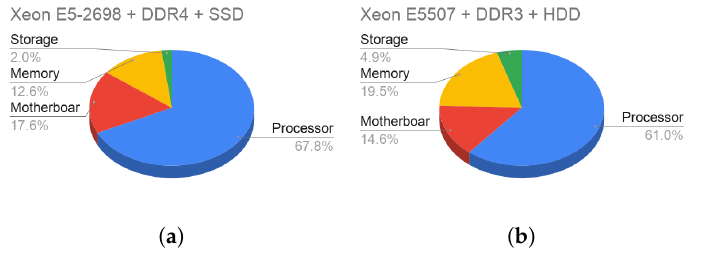
Figure 1. Power breakdown of a typical node of an HPC cluster at full use. The system used in this study ( a ) was built in 2016 and equipped with two Intel Xeon E5-2698, 128 GB of DDR4 memory and SSD as storage, while ( b ) the case study in [11] was built in 2012 and equipped with two Xeon E5507, 32GB of DDR3 memory and HDD as